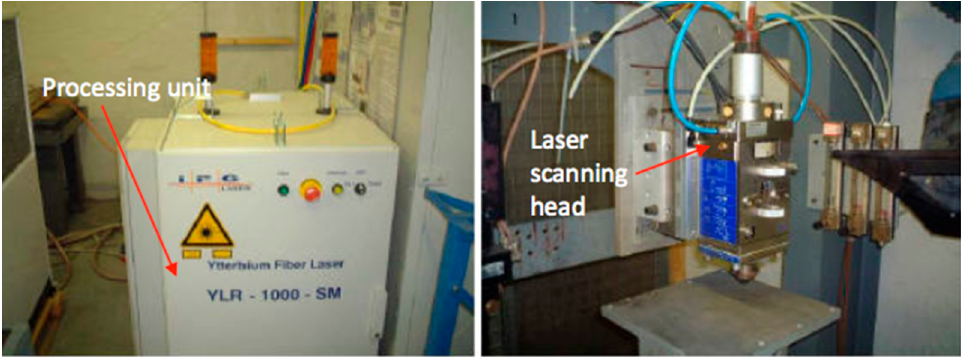
Figure 1. IPG single ‐ mode YLR ‐ 1000 ‐ SM 1 kW fiber laser.